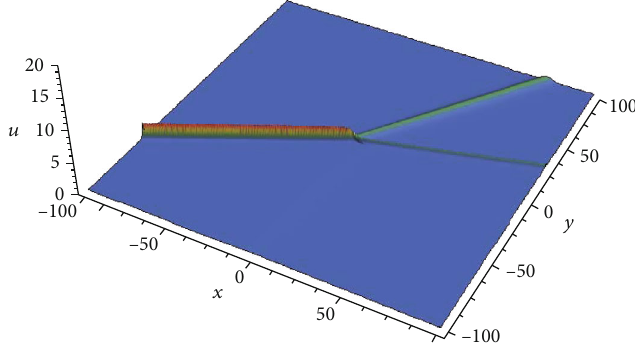
Figure 13: Y-type interaction in the fractional line three-soliton solution u with α = 83/99 , a = 0 , b = 0 , c = 0 , k p 1 = − 1/4 , p 2 = − 3/4 , p 3 = − 7/4 , σ = 1 , ξ ð